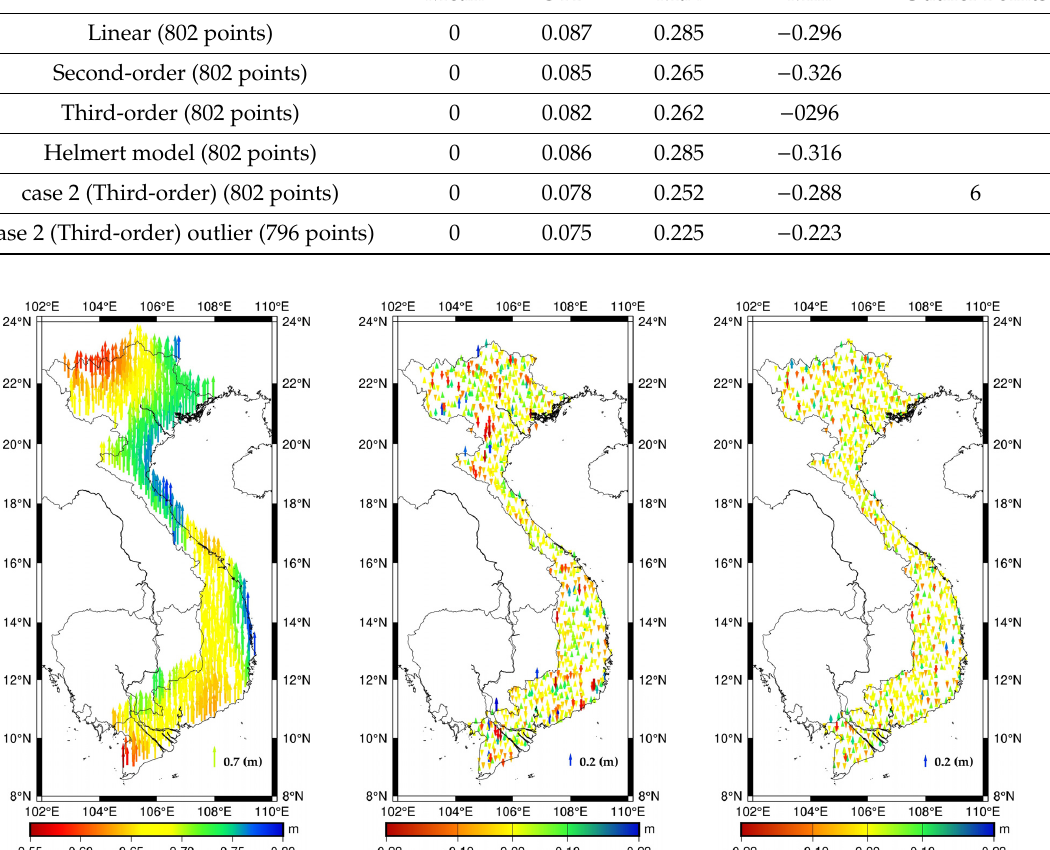
Table 5. Residual of the di ff erences between GNSS / levelling data and GEOID_LSC model. Unit: (m).